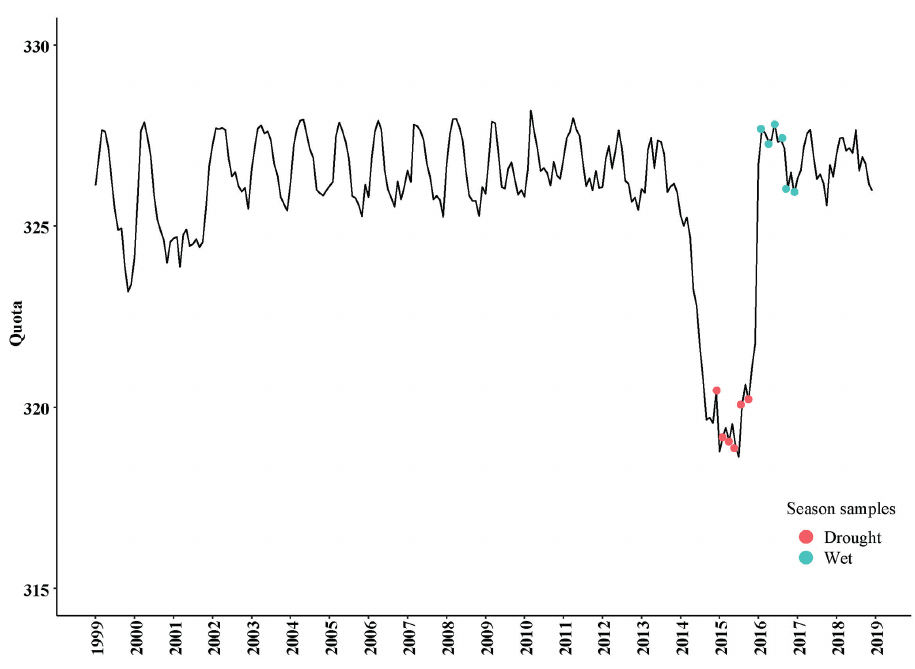
FIGURE 2 | Historical series of the variation in quota (m) between 1999 and 2019 in the Ilha Solteira reservoir, Upper Paraná River, São Paulo, Brazil. The dots indicate the sampling